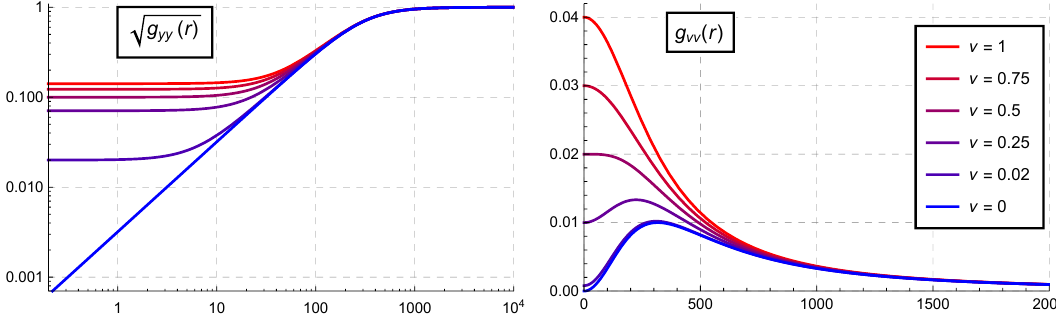
√ Figure 1 . Left: the log-log plot of g yy , which determines the proper length of the S 1 ( y ) circle, as a function of the radial coordinate for different values of ν , defined in (4.52). For ν = 0 the y -circle pinches off at r = 0 , followed by a region of linear increase indicating an AdS 3 spacetime. At large values of r the circle stabilises signalling the onset of the asymptotically flat region. For ν 6 = 0 there is another region where the size of the S 1 ( y ) -circle is constant due to the AdS 2 × S 1 throat region. With increasing ν the transition between the AdS 3 and the throat region appears at larger values of r . Right: plot of g vv ( r ) , which contains the information about the momentum of the system, for various values of ν , while keeping Q P fixed to ensure equal asymptotic behaviour. For ν = 1 the source of the momentum is completely localised at the origin. By decreasing the value of ν , the value of the metric component at r = 0 is decreasing until it vanishes at ν = 0 . At the same time, a new maximum appears, signalling that the source of momentum is a null wave orbiting the centre. In both plots we took Q 1 = Q 5 = 10 5 and Q P = 2 × 10 3